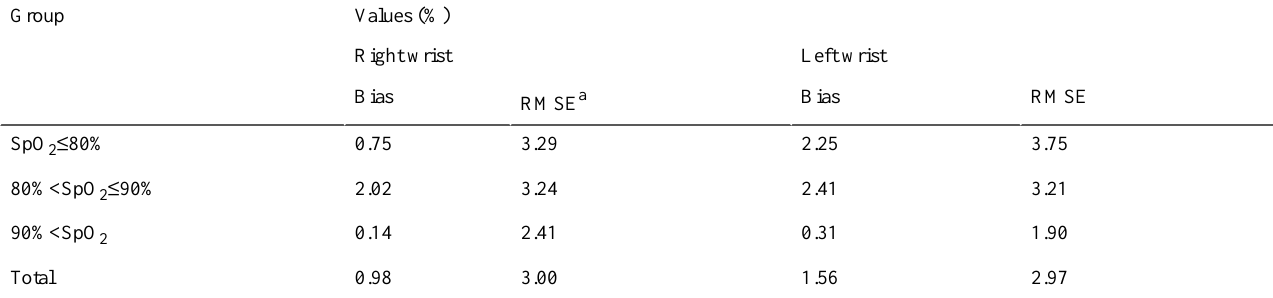
Table 4. Bias and RMSE found from the Withings ScanWatches placed on the participants’right and left